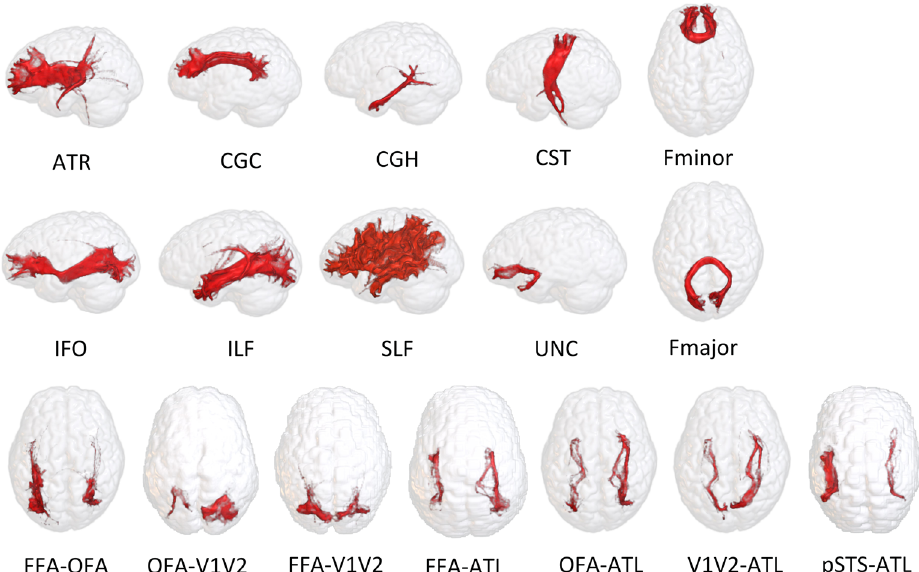
Figure 7. Ten global fibers and seven functionally defined face fibers from representative individual brains traced in the current study. Displayed individuals were selected according to their white matter connection to provide a clear visualization of the traced fibers. ATR—anterior thalamic radiation; CGC—cingulate gyrus part; CGH—cingulum in the hippocampal part; CST—corticospinal tract; IFO—inferior frontooccipital